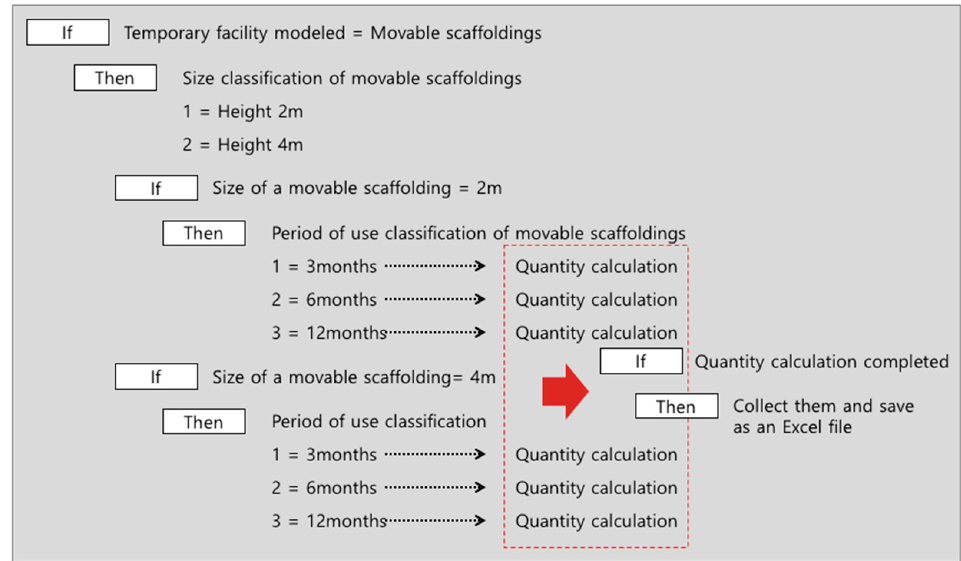
Figure 9. Temporary facilities quantity inspection module—dynamo calculation rule.